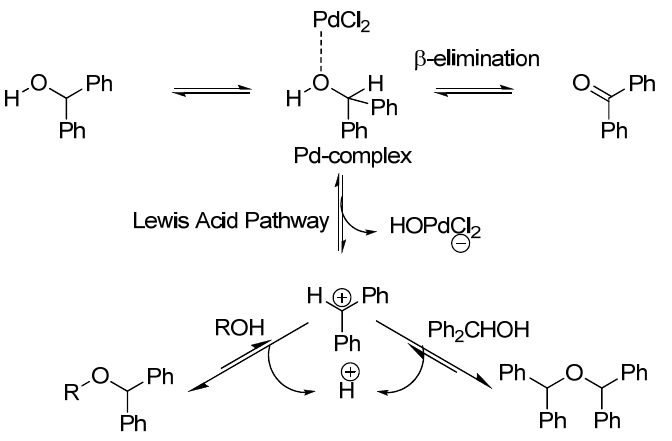
Scheme 2. Mechanism for diphenylmethyl ether